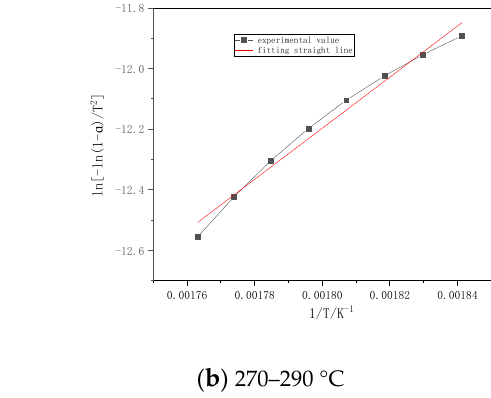
Figure 7. Fitting straight line for burning stages of poplar.